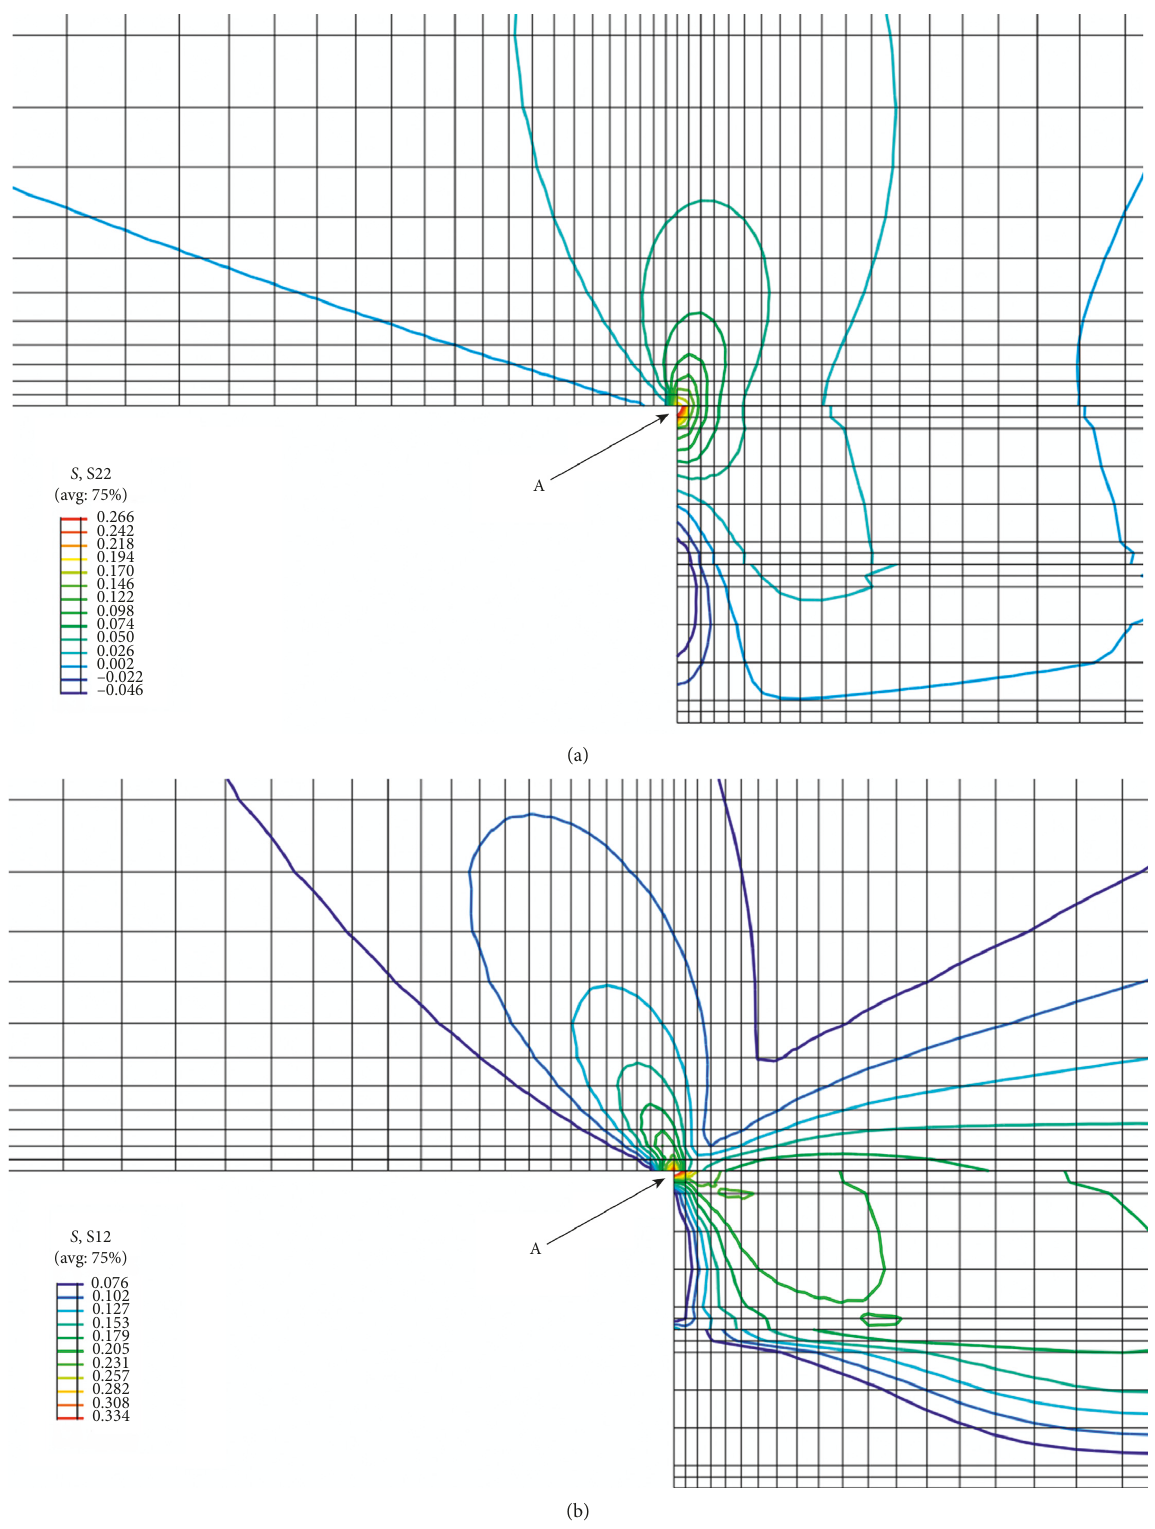
Figure 12: Contours of stress near the plate end (MPa). (a) Vertical normal stress. (b) Shear